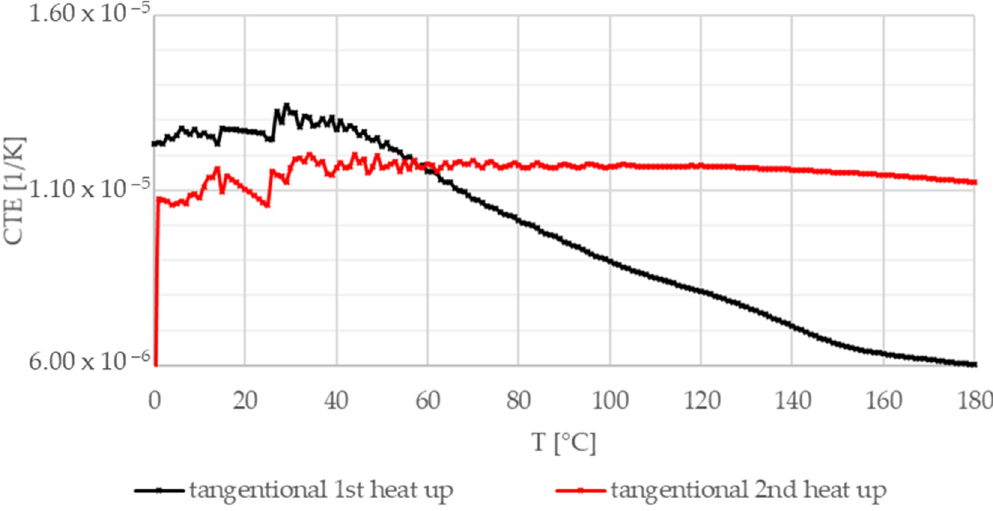
Figure 17. Coe ffi cient of thermal expansion—tangential direction, two heat-up loops (black, Figure 17. Coefficient of thermal expansion—tangential direction, two heat-up loops (black, red).